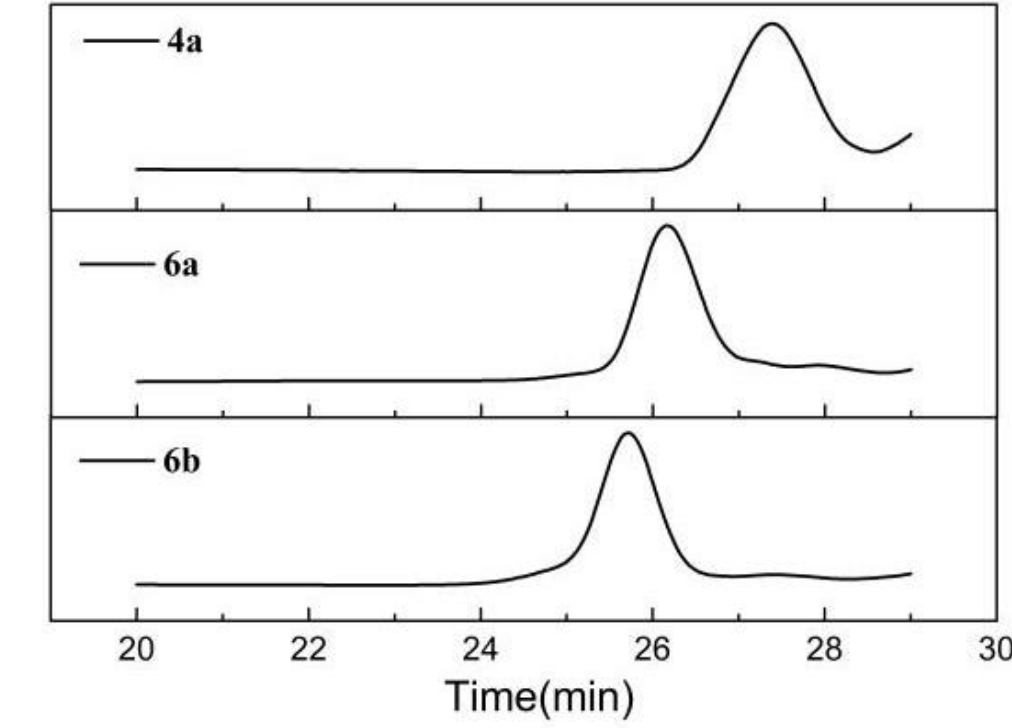
Figure 1. GPC spectra of 4a , 6a , and 6b . Table 1. Reaction conditions for the synthesis of surfactants 4 and 6 .